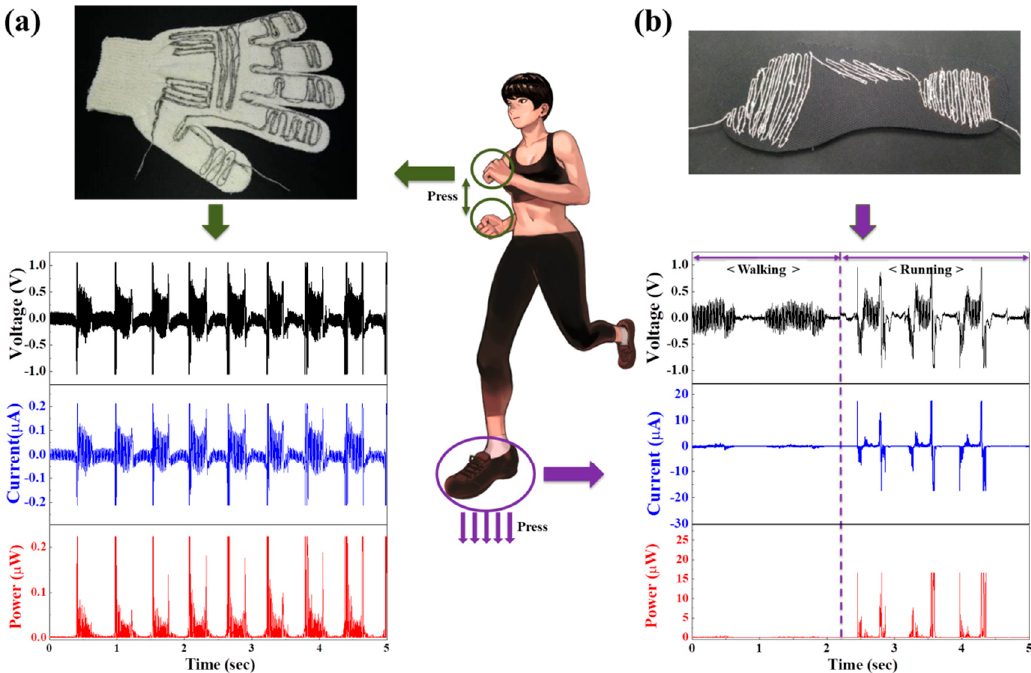
Figure 5. ( a ) Output voltages, output currents, and output powers according to clapping movements as a cotton glove stitched in the e ff ective area with the core-shell piezoelectric yarns is worn, and ( b ) output voltages, output currents, and output powers according to walking and running movements as a shoe insole stitched in the e ff ective area with the core-shell piezoelectric yarns is worn.